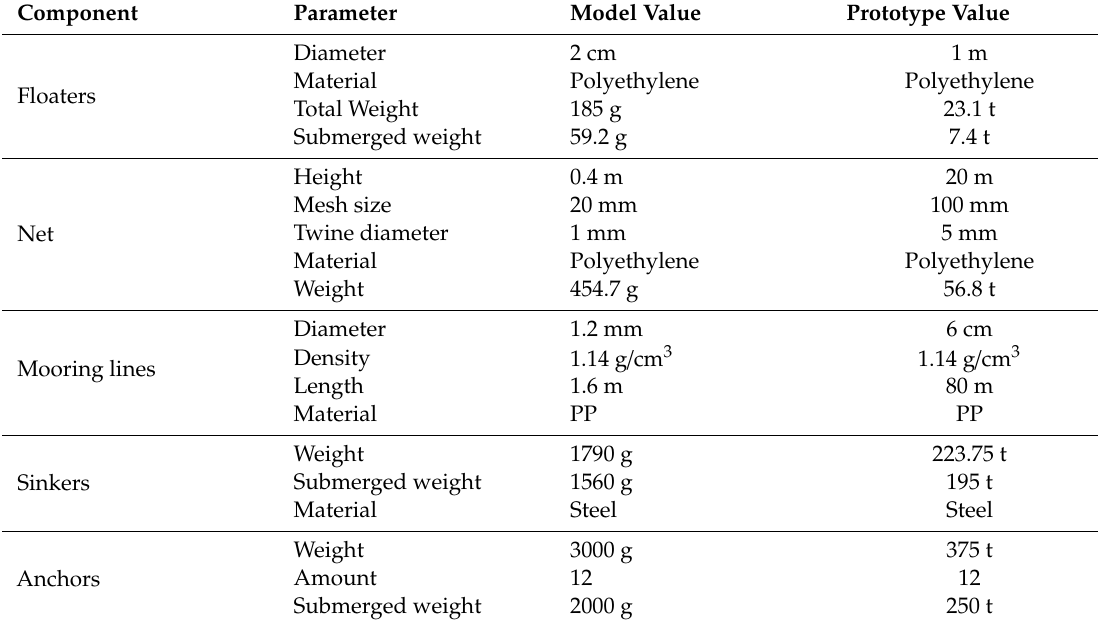
Table 2. Parameter of the floating rope enclosure.